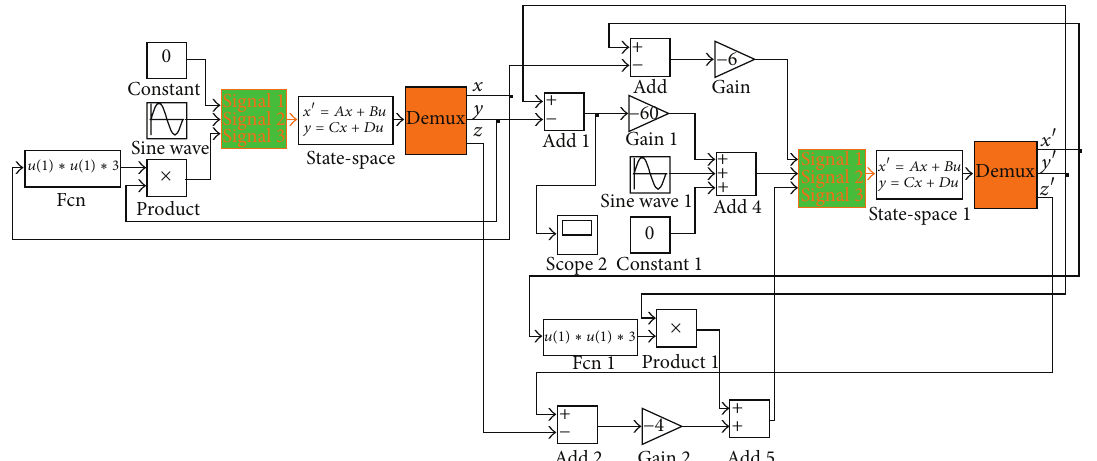
Figure 8: State feedback simulation system.